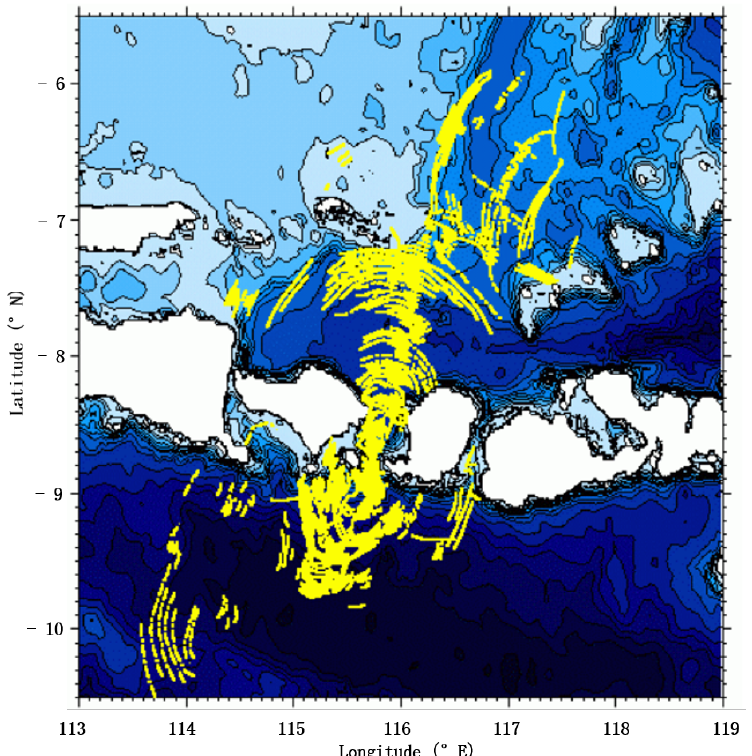
Figure 3. Composite map showing internal wave crests from all available images covering the Bali Sea region. From